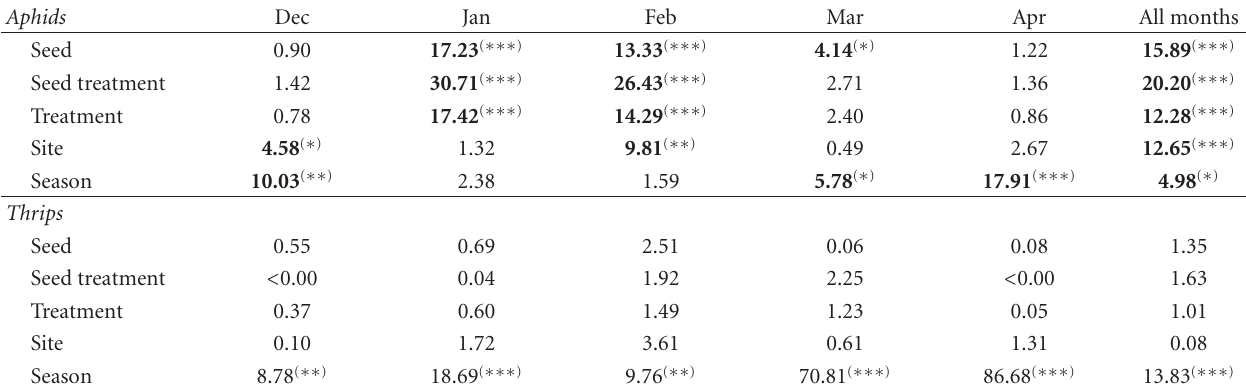
Figure 4: Average (s.e.) canola plant weights in response to grouped counts of aphids (a) and thrips (b). Aphid counts were divided into three classes (class 0 = plants without aphids (38% of observations), class 1 = 1–15 aphids per plant (32% of observations), and class 2 > 15 aphids per plant (30% of observations)). Thrips data were divided into presence (class = 1; 25% of observations) and absence (class = 0; 75% of observations). ∗ : significant di ff erence at the 0.05 level, ∗∗ : significant di ff erence at the 0.01 level, and ∗∗∗ : significant di ff erence at the 0.001 level. Table 3: F values from nonparametric analysis of grouped densities of aphids and thrips on canola